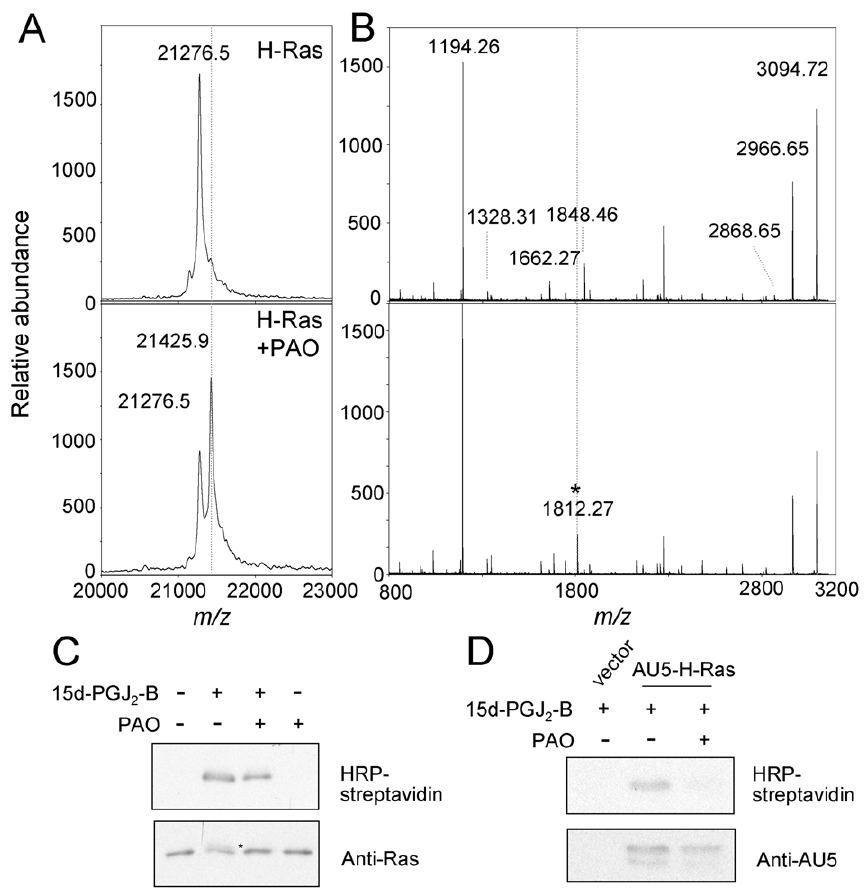
Figure 4. PAO binds to the C-terminal peptide of H-Ras in vitro and in cells. (A) Full length H-Ras was incubated with PAO and analyzed by MALDI-TOF MS. (B) Control or PAO-treated H-Ras was subjected to tryptic digestion and the resulting peptides analyzed by MALDI-TOF MS. The peak of m/z 1812.27, corresponding to the formation of an adduct between PAO and the K170-K185 peptide, is marked by an asterisk. Dotted lines mark the positions equivalent to those of the modified species in the untreated samples. (C) H-Ras at 5 m M was incubated with 50 m M PAO for 30 min before addition of 1 m M biotinylated 15d-PGJ 2 (15d-PGJ 2 -B) for 1 h. (D) COS-7 cells were transiently transfected with empty vector or a plasmid coding for AU5-H-Ras. 24 h after transfection cells were pre-treated with vehicle or 1 m M PAO for 90 min before incubation with 5 m M 15d-PGJ 2 -B for 90 min. Incubation mixtures from (C) and cell lysates from (D) were analysed by SDS-PAGE followed by transfer to membrane and detection of incorporated biotin with horseradish peroxidase (HRP)-streptavidin and of the Ras protein by immunoblot with anti-pan Ras or anti-AU5 antibody and enhanced chemiluminescence (ECL). Results shown are representative of at least three assays.